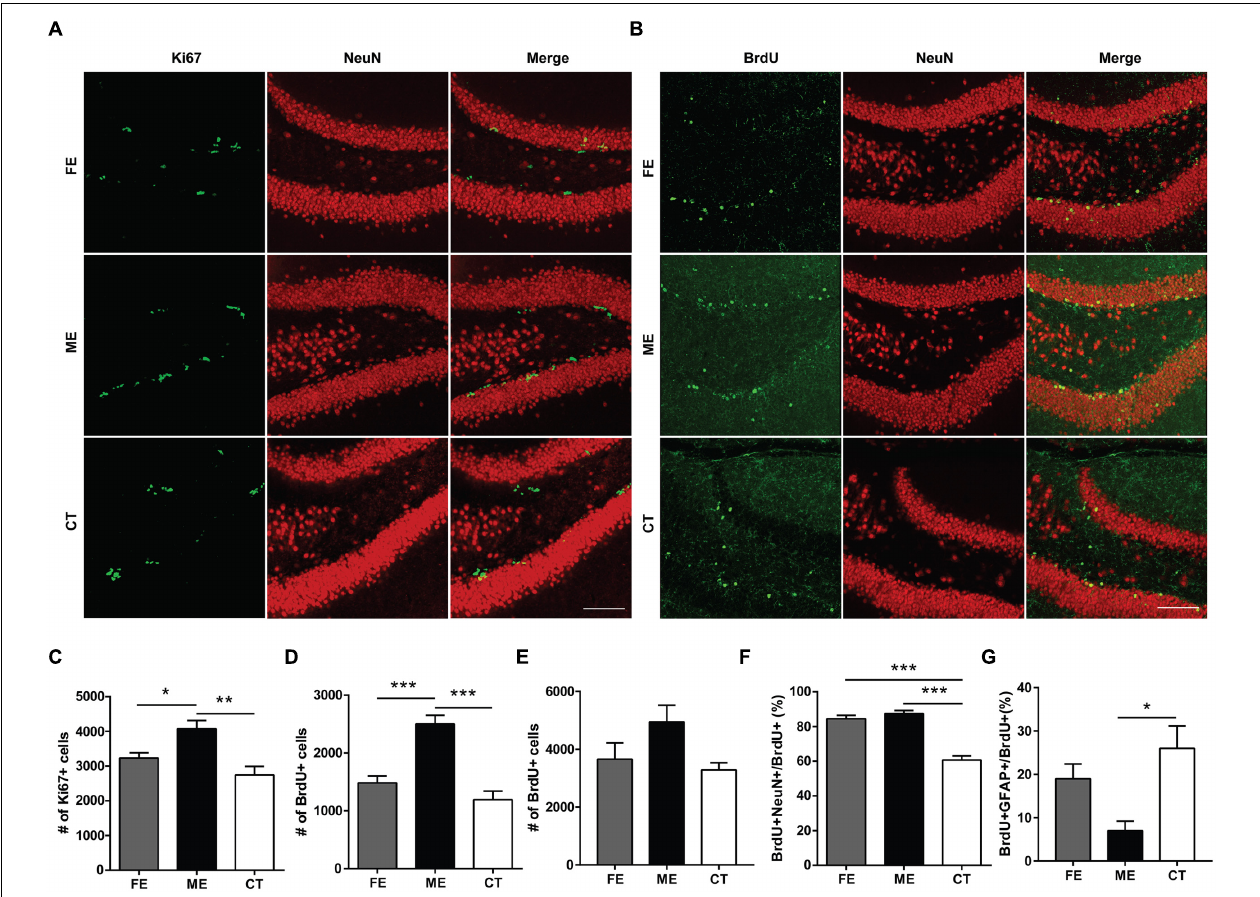
FIGURE 2 | Cellular proliferation, differentiation, and survival in the dentate gyrus (DG) of mice subjected to distinct training paradigms. (A) Representative images of Ki67 + cells and their colocalization with NeuN in FE, ME, and CT mice, respectively. Scale bar = 100 µ m. (B) Representative images of BrdU + cells and their colocalization with NeuN in FE, ME, and CT mice, respectively. Scale bar = 100 µ m. (C) Quantification of Ki67 + cells reveals a significant decrease in their total number in FE mice when compared to ME mice. One-way ANOVA, F 2 , 12 = 9.429, P = 0.0035; post hoc test: ME vs. FE: ∗ P < 0.05; ME vs. CT: ∗∗ P < 0.01; FE vs. CT: P > 0.05; n = 5 in each group. (D) Quantification of BrdU + cells reveals a significant decrease in their total number in FE mice as compared to ME mice. One-way ANOVA, F 2 , 12 = 24.06, P < 0.0001; post hoc test: ME vs. FE: ∗∗∗ P < 0.001; ME vs. CT: ∗∗∗ P < 0.001; FE vs. CT: P > 0.05; n = 5 in each group. (E) Cellular proliferation in the DG of mice subjected to 2-week training. Quantification of BrdU + cells reveals no significant change in their total number in FE or ME mice. One-way ANOVA, F 2 , 12 = 3.254, P = 0.0743; n = 5 in each group. (F) Quantification of the ratios of BrdU + NeuN + cells to BrdU +